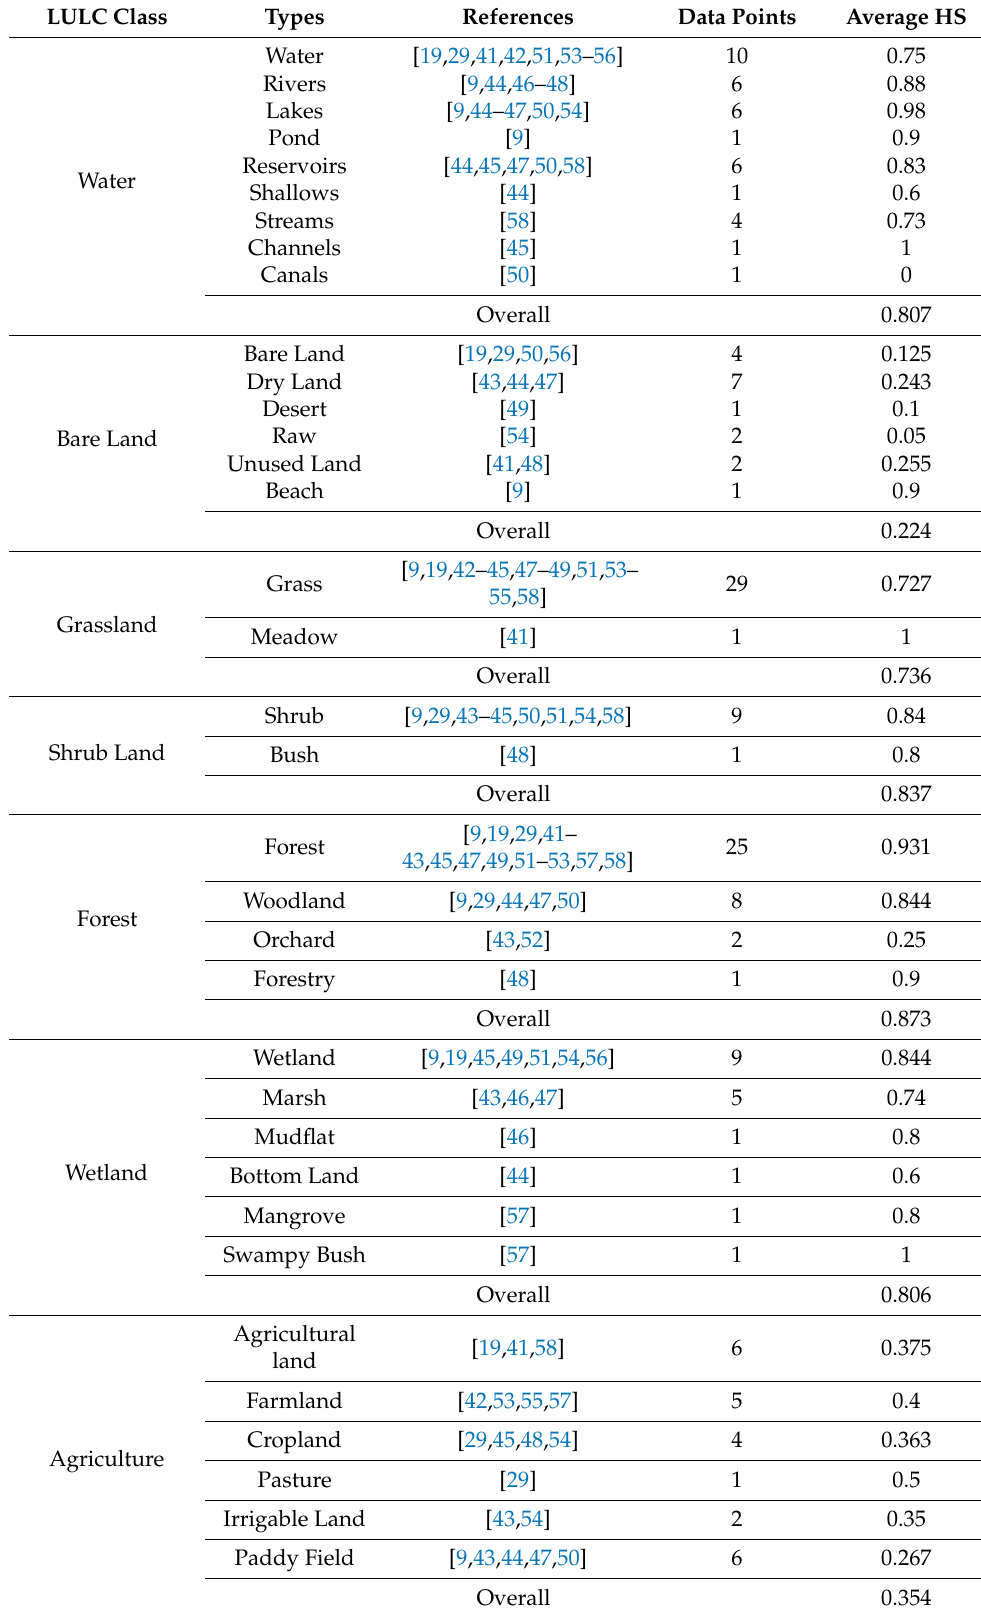
Table 2. The average habitat suitability for each land use/cover type obtained from the literature